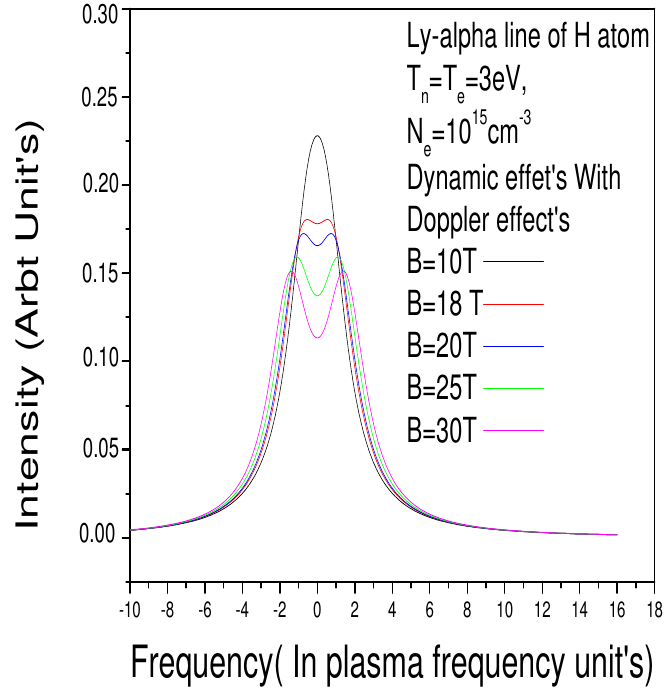
Figure 3. Lyman Alpha line in the hydrogen plasma with the MSE and Doppler effects and without the fine structure